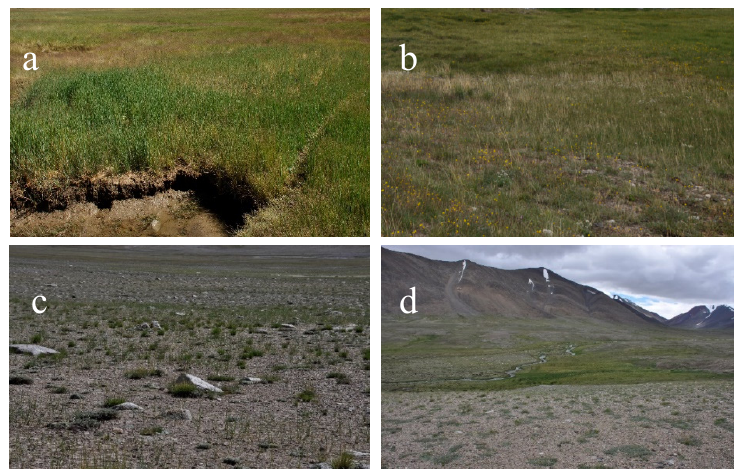
Figure 2. Summer fieldwork involved geotagging of vegetation communities based on three classes: ( a ) dense; ( b ) medium dense; and ( c ) sparse. The sample photo in ( d ) shows the transition between different classes. Geotagged locations are essential for classification and accuracy assessment.